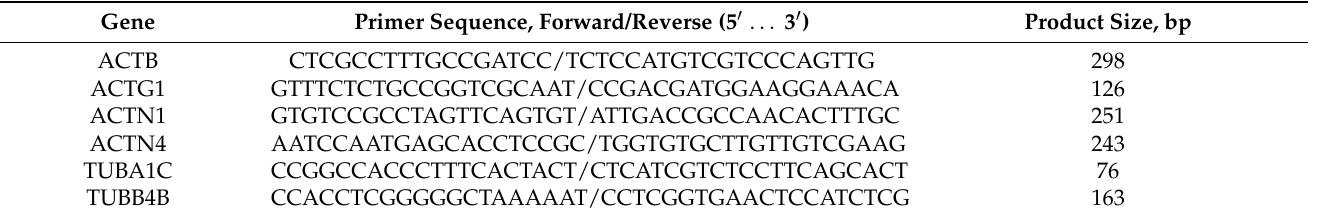
Table 2. Primer sequences and product